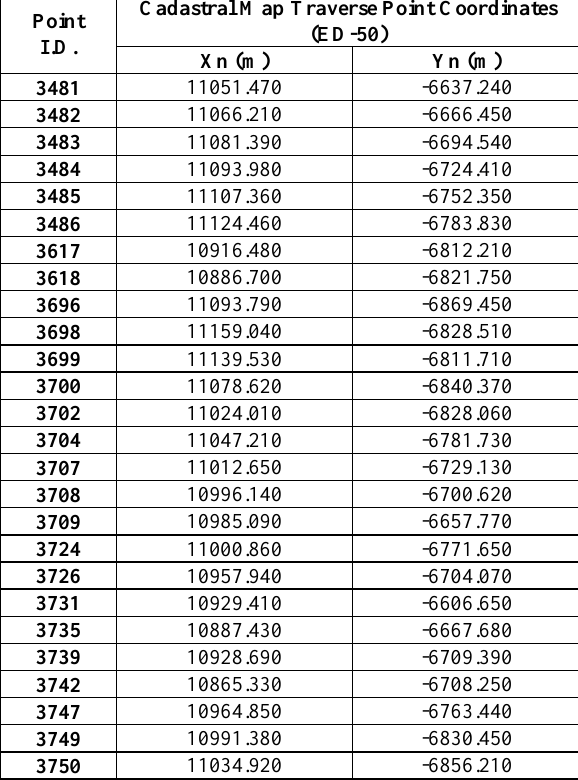
Table 2. Cadastral map traverse point coordinates